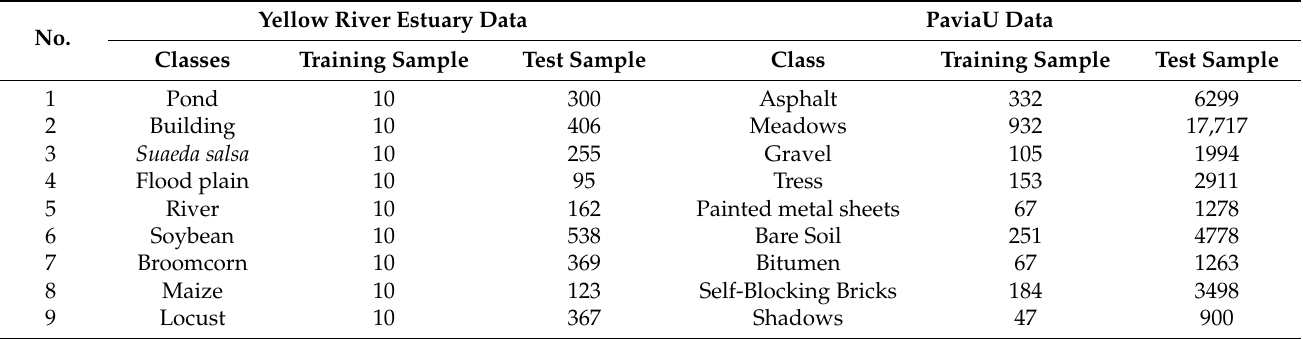
Figure 1. The distribution of false-color image maps and ground sample data: ( a ) false-color image for Yellow River Estuary data; ( b ) ground truth distribution map for Yellow River Estuary data; ( c ) false-color image map for Pavia University data; ( d ) ground truth distribution map for Pavia University data. Table 1. Training sample of datasets.